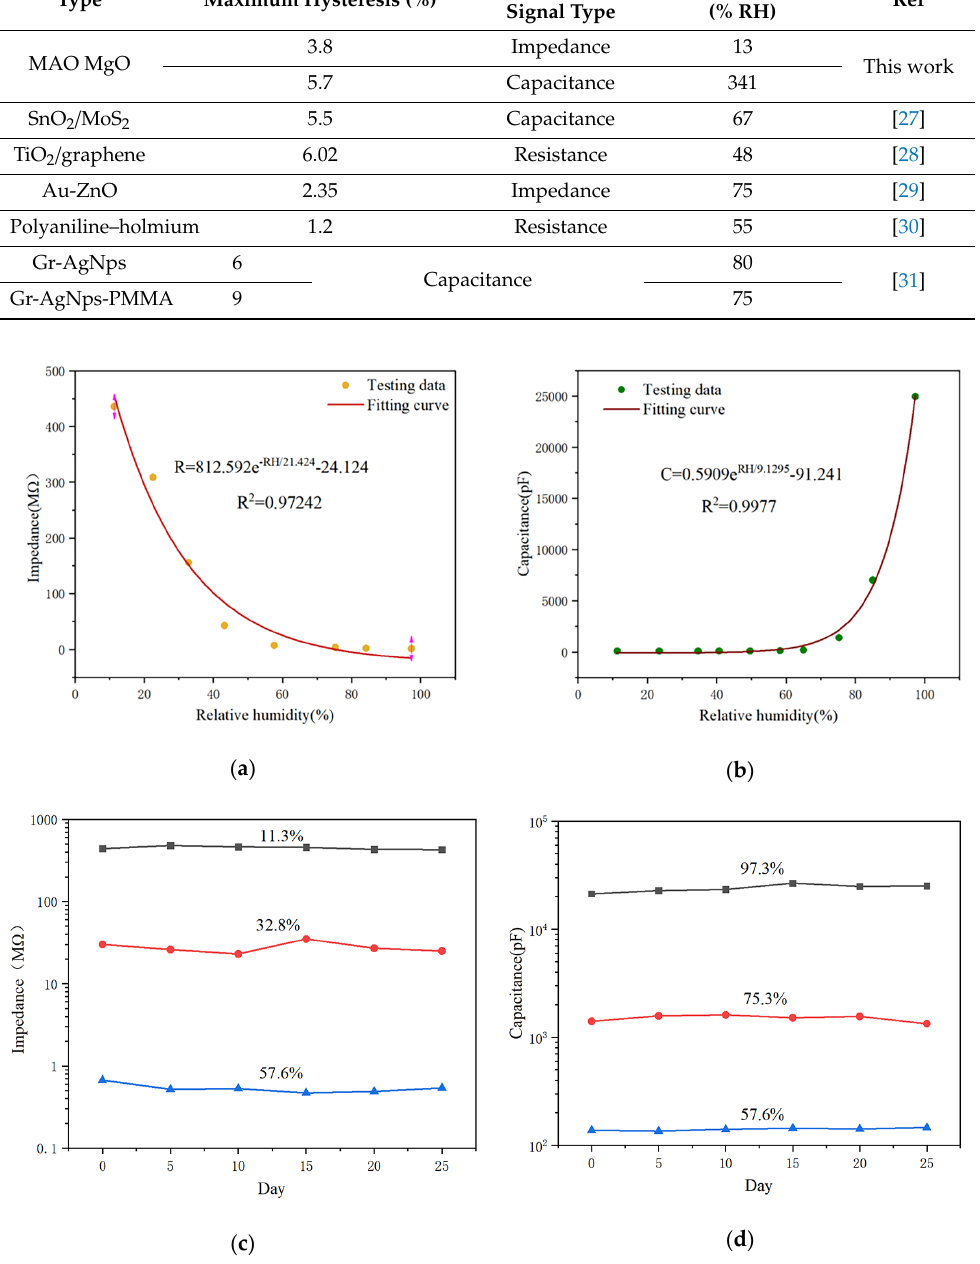
Figure 8. Sensor response as a function of RH in the range of 11.3%–96.3% RH for the ( a ) impedance and ( b ) capacitance as micro-arc MgO humidity sensor response signal, the ( c ) impedance and ( d ) capacitance are used as the response signals of the micro-arc MgO humidity sensor, with good stability in low humidity and high humidity environments respectively.